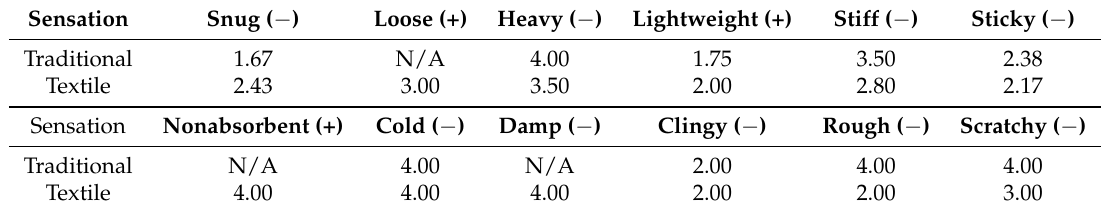
Table 4. Set of descriptive sensation words selected by subjects and average